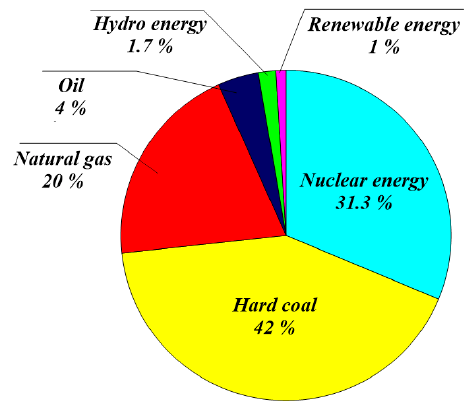
Figure 3. Energy source fractions of electricity in Republic of Korea (ROK).